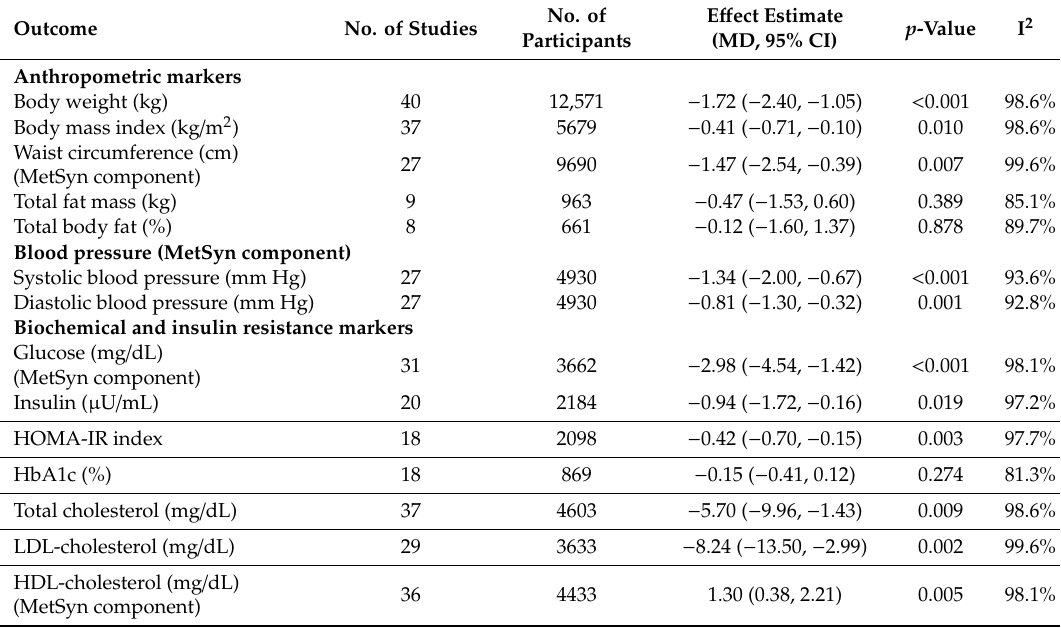
Table 2. EffectoftheMediterraneandietonanthropometric, bloodpressure, biochemical, insulinresistance, oxidative stress, inflammatory, and endothelial function markers related to the metabolic syndrome *. No. of Outcome No. of Studies